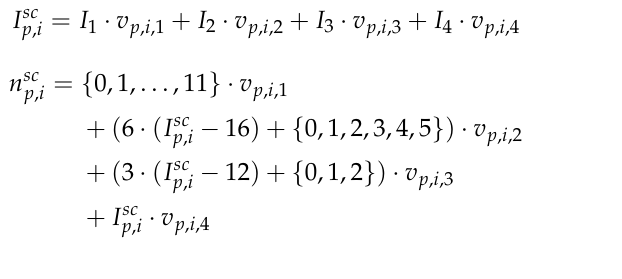
Table 5. Subcarrier indication field values and its corresponding RU type and subcarrier sets. Subcarrier Indication Value ( I sc